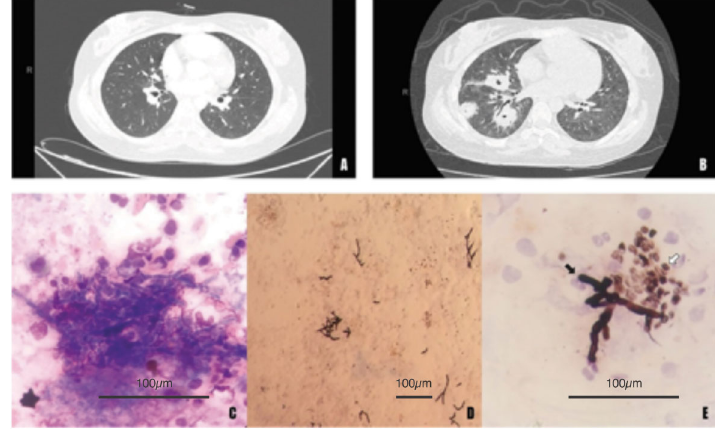
Figure 1. Aspects of chest tomography at admission ( A ) and after fi fteen days of evolution ( B ) with the presence of excavated nodules with halo signal, initially considered to be of in fl ammatory/infectious etiology. C, Sample of bronchoalveolar lavage showing presence of macrophages, lymphocytes, neutrophils, and many hyphae and yeasts (Leishman staining, 600 (cid:1) ). D and E , Presence of non-speci fi c septate hyphae (black arrow) and yeasts (white arrow) suggestive of Pneumocystis jirovecii (silver methenamine staining, 200 and 600 (cid:1) , respectively). Scale bars: 100 m